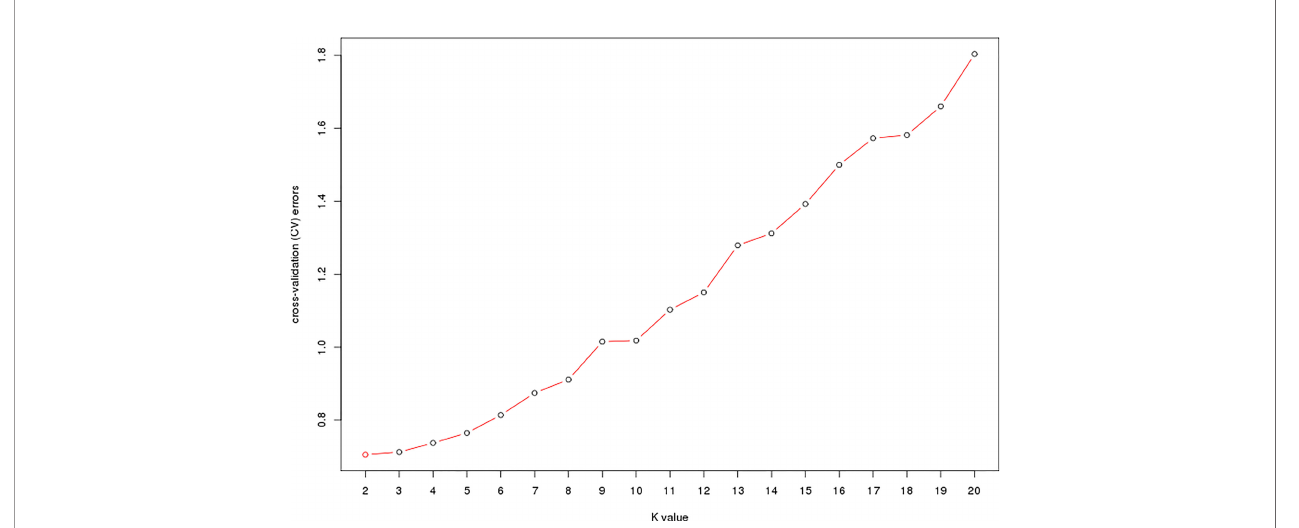
FIGURE 5 | ADMIXTURE estimation of the number of groups for K values ranging from 2 to